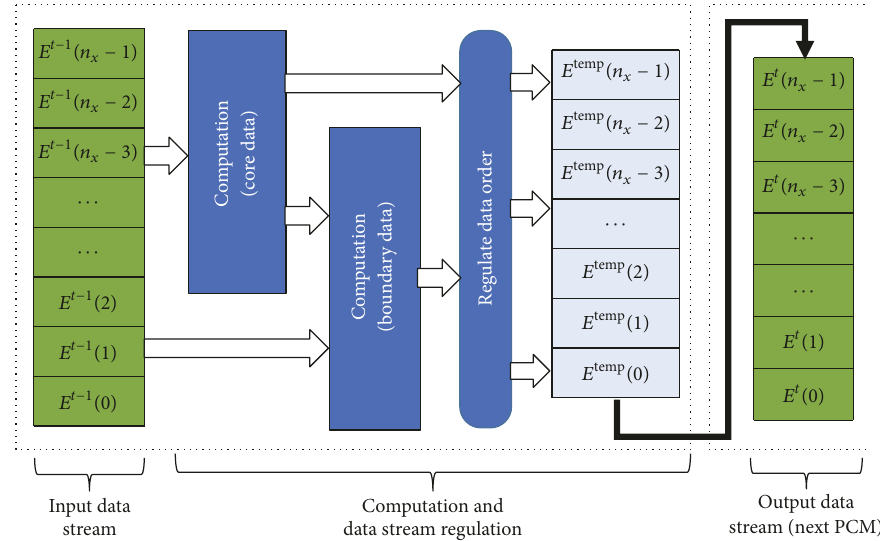
Figure 7: Proposed pipelined computation module (PCM). Computed data are arranged in the correct order to preserve the regularity of the data